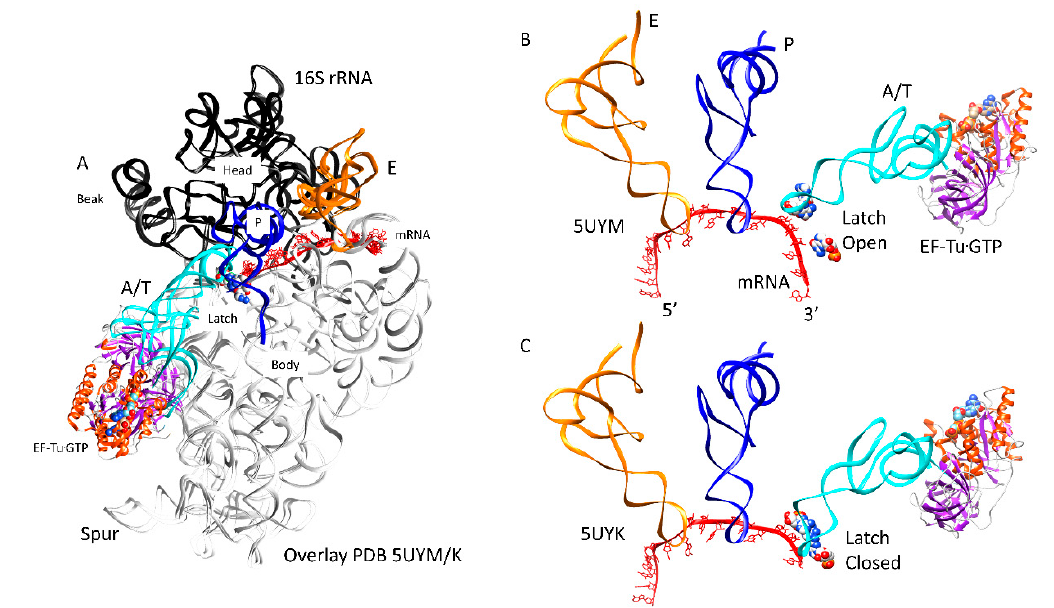
Figure 5. Closing of the codon-anticodon latch closes the 30S ribosomal subunit; ( A ) overlay of open and closed latch structures. The head and beak are black (16S: 930–1380). The body is white. tRNA sites locate to the cleft between the head/beak and the body; ( B ) the latch is open (complex 1); ( C ) the latch is closed (complex 3). This transition occurs in three stages (Table 1).